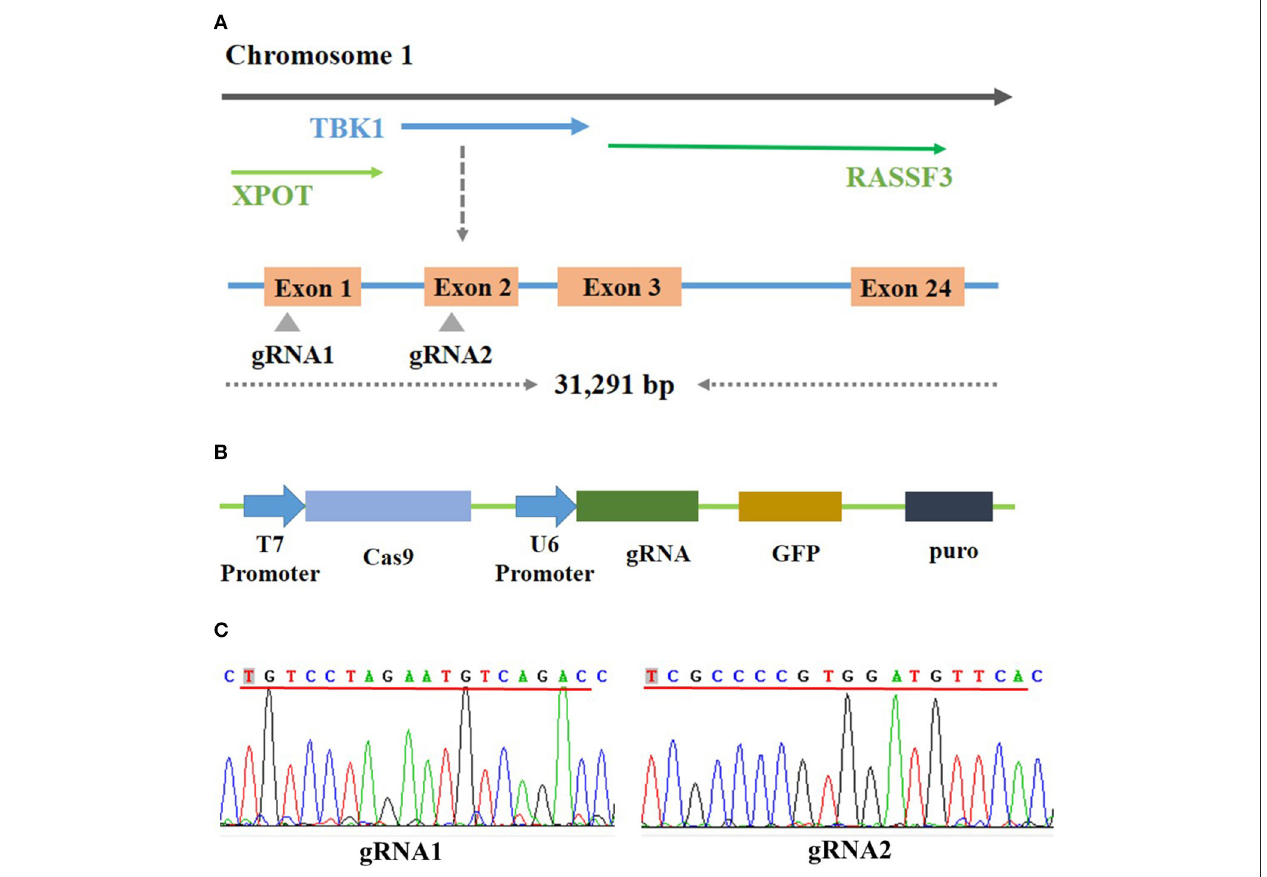
FIGURE 1 | Construction of CRISPR/Cas9 vector. (A) Schematic diagram of chicken TBK1 gene and target-site position. Two target sites were designed based on the sequence at exons 1 and 2. (B) Schematic diagram of CRISPR/Cas9 vector used in this study. (C) Sequencing results showing that gRNA1 and gRNA2 have been completely connected to the CRISPR/Cas9